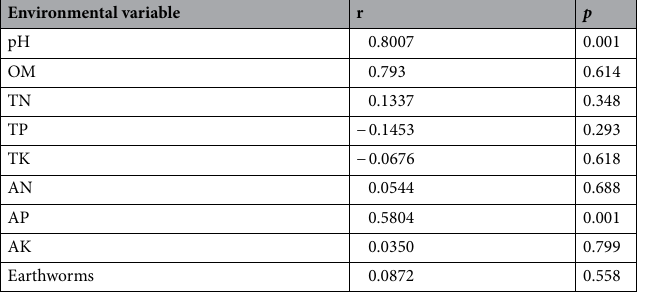
Table 3. Spearman correlations (r) between the relative abundances of bacterial orders and the environmental variables determined by the Mantel test. pH hydrogen ion concentration, OM soil organic matter, TN total nitrogen, TP total phosphorus, TK total potassium, AN alkali-hydrolyzable nitrogen, AP available phosphorus, AK available